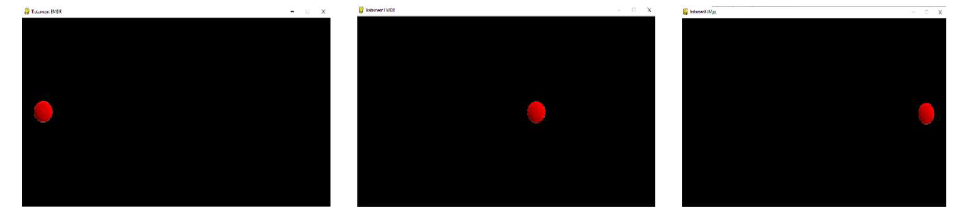
Figure A1. Chat window used for communication between the chatbot module and users.